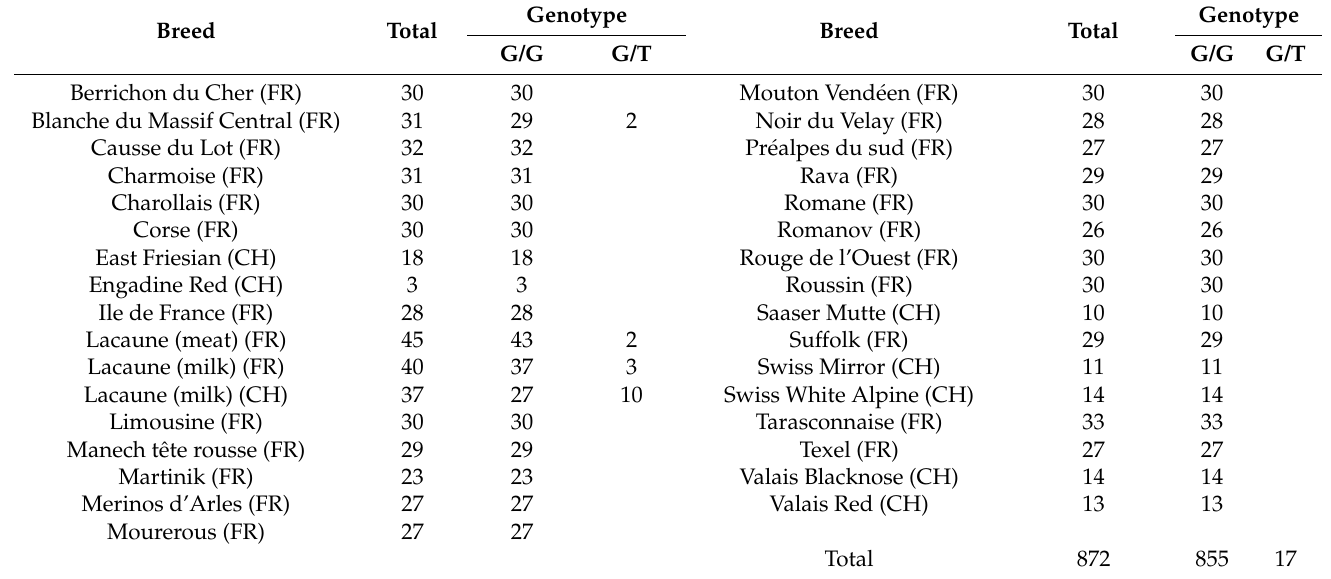
Table 3. CCDC65 c.521G > T genotype distribution from a DNA diversity panel of French (FR) and Swiss (CH) ovine